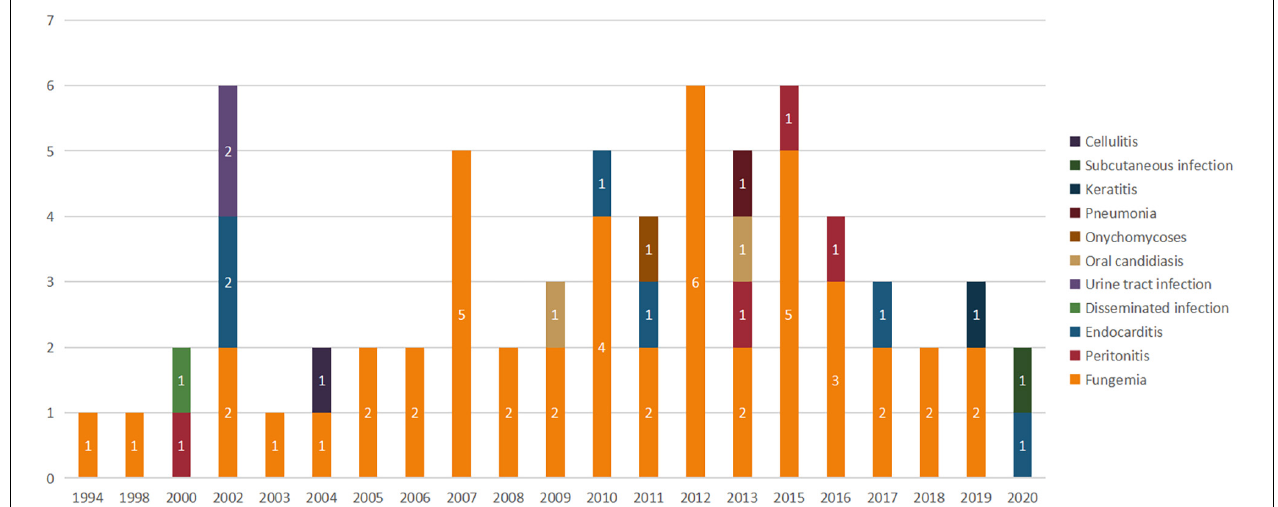
FIGURE 2 | Timeline of published K. ohmeri infections. No., number of publications.